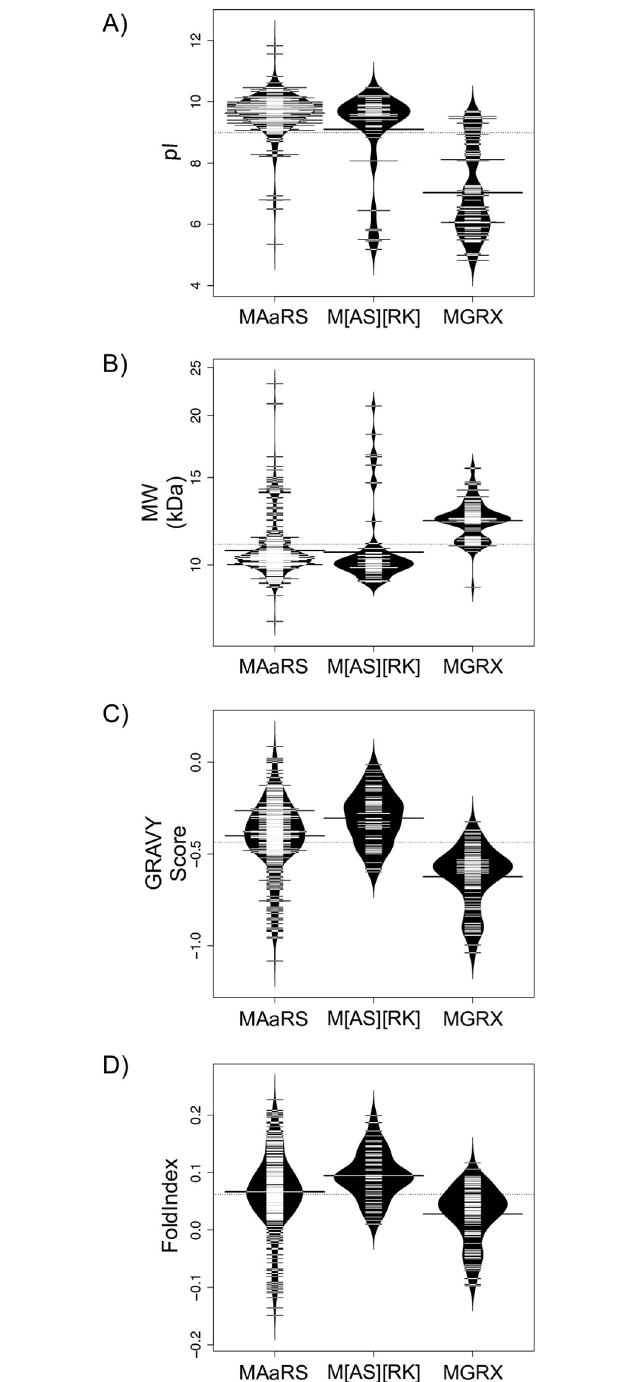
Fig 4. Physiochemical properties of LEA3 proteins. Bean plots of the A) isoelectric point (pI), B) molecular weight (MW), C) GRAVY score and D) FoldIndex score of LEA3 proteins grouped by the three major N-terminal architectures. The thin bars show the value of an individual protein, the wider black bar shows the mean value of an architecture, and the dotted line shows the mean value of all protein sequences. The violin shape shows the density of the property